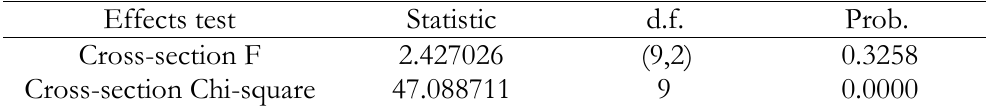
Chow Test Results of Energy Company Data in